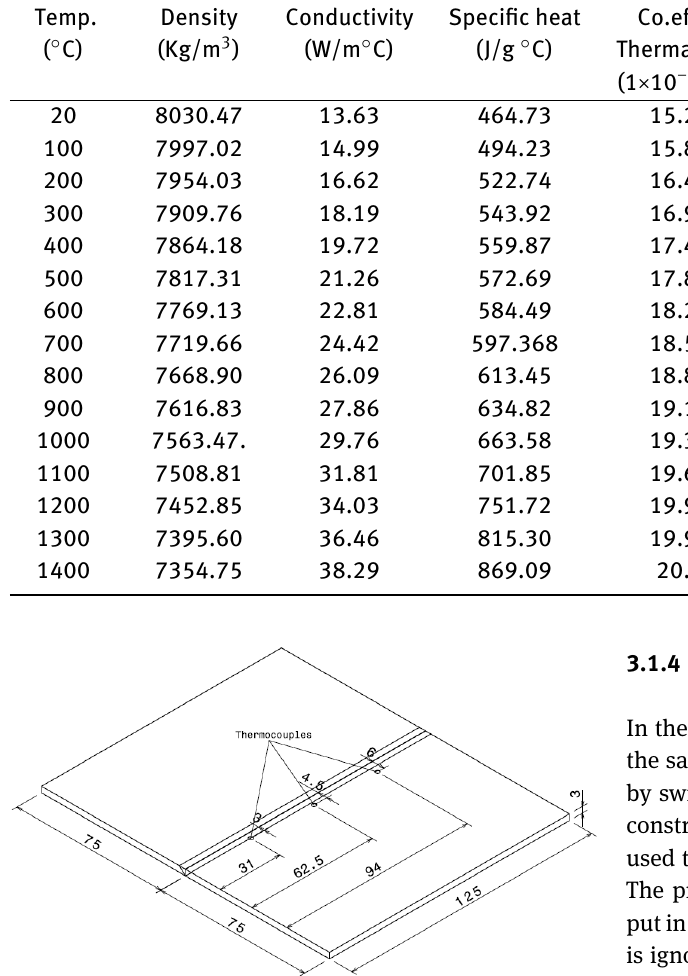
Table 1: Thermo-mechanical properties of 316 Stainless Steel. Temp.